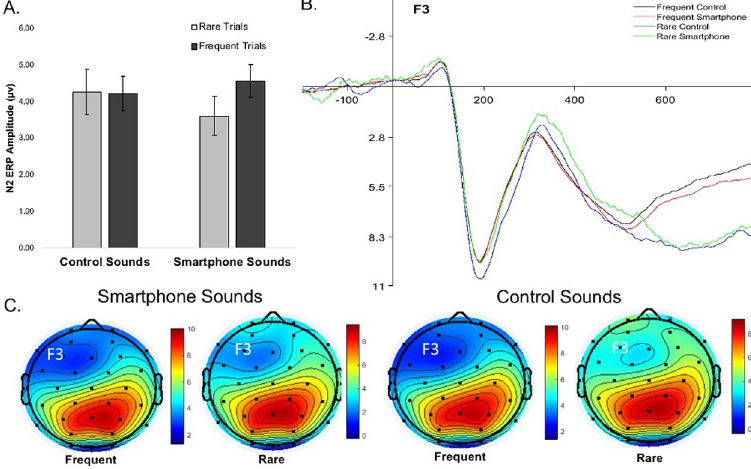
Fig 6. N2 ERPs for trial frequency and sound conditions. N2 ERP amplitudes on rare and frequent trials with smartphone and control sounds. The oddball effect is difference between rare and frequent trials. a N2 is a negative going potential, thus smaller values indicate larger ERP amplitude. A) Bar chart of mean N2 amplitudes. B) ERP waveforms for frequent trials with control sounds (black line), frequent trials with smartphone sounds (red line), rare trials with control sounds (blue line), and rare trials with smartphone sounds (green line). C) Scalp maps of N2 at 300 ms for frequent and rare trials after delivery of the sound